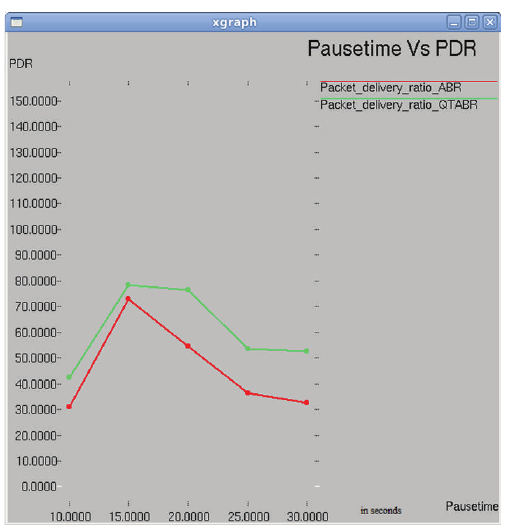
Figure 8: Pause time versus